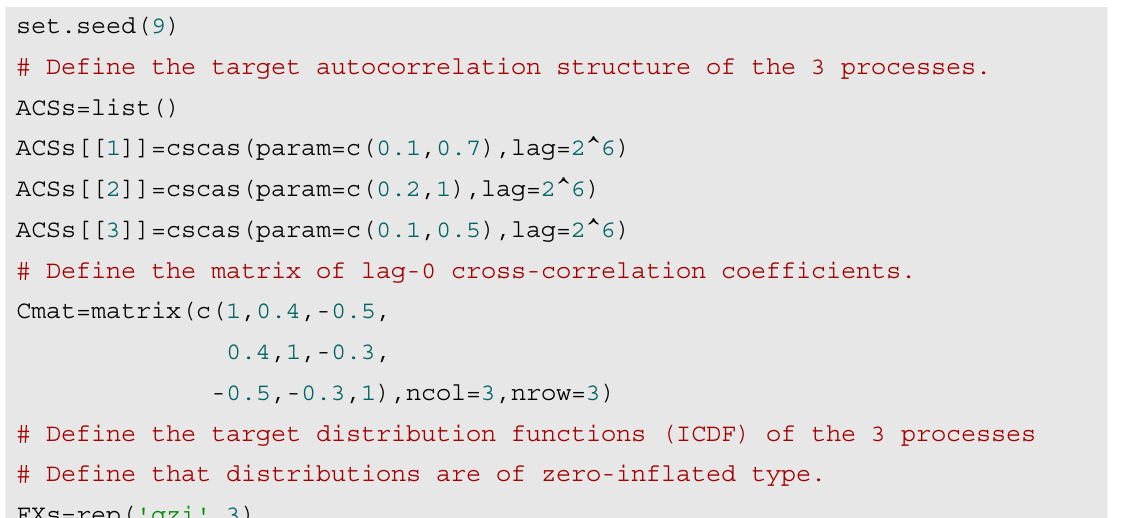
Box 7. R-code for the simulation of multivariate stationary processes with specific distribution functions and autocorrelation structures, as well as specific lag-0 cross-correlation